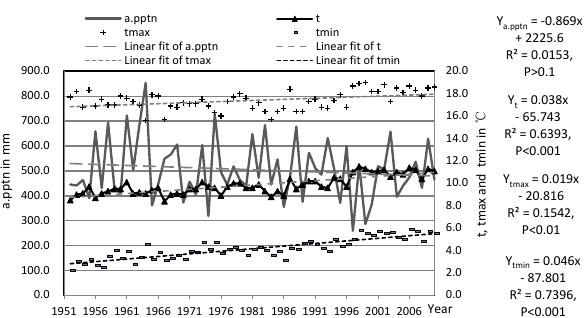
Y S = -1.321x + 2820.3 R 2 = 0.0928, sig.=0.019